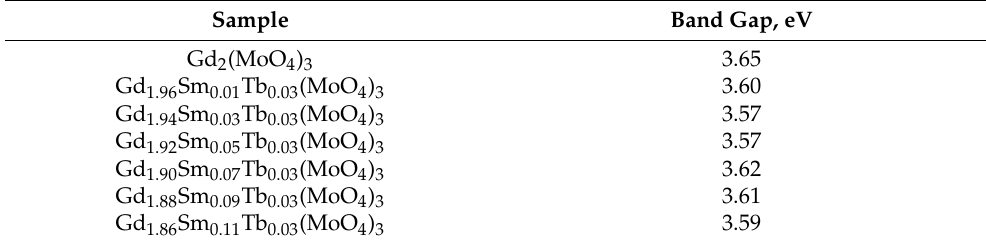
Table 2. The band gap values decreased compared with those of the pure Gd 2 (MoO 4 ) 3 sample. The changes were not monotonous with the Sm content increase. Table 2. Band gap values of the Gd 1.97 − y Sm y Tb 0.03 (MoO 4 ) 3